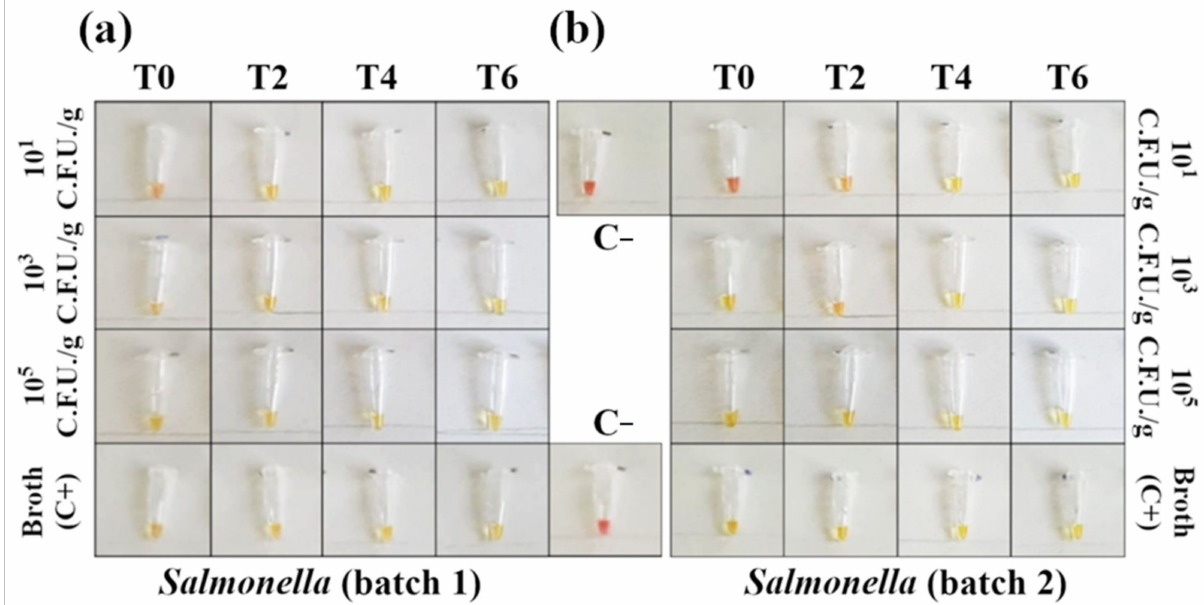
Figure 4. Detection of Salmonella DNA in contaminated minced chicken meat using colorimetric LAMP (amplification time 45 (cid:48) ). Negative samples are red and positive samples are yellow. ( a ) In the first batch of minced meat, the reaction detected 10 1 CFU/g with no need for an enrichment phase. ( b ) For the second batch, the reaction amplified 10 1 CFU/g after 2 h of enrichment. Each sample was tested in triplicate (see Figures S3 and S5 for the complete